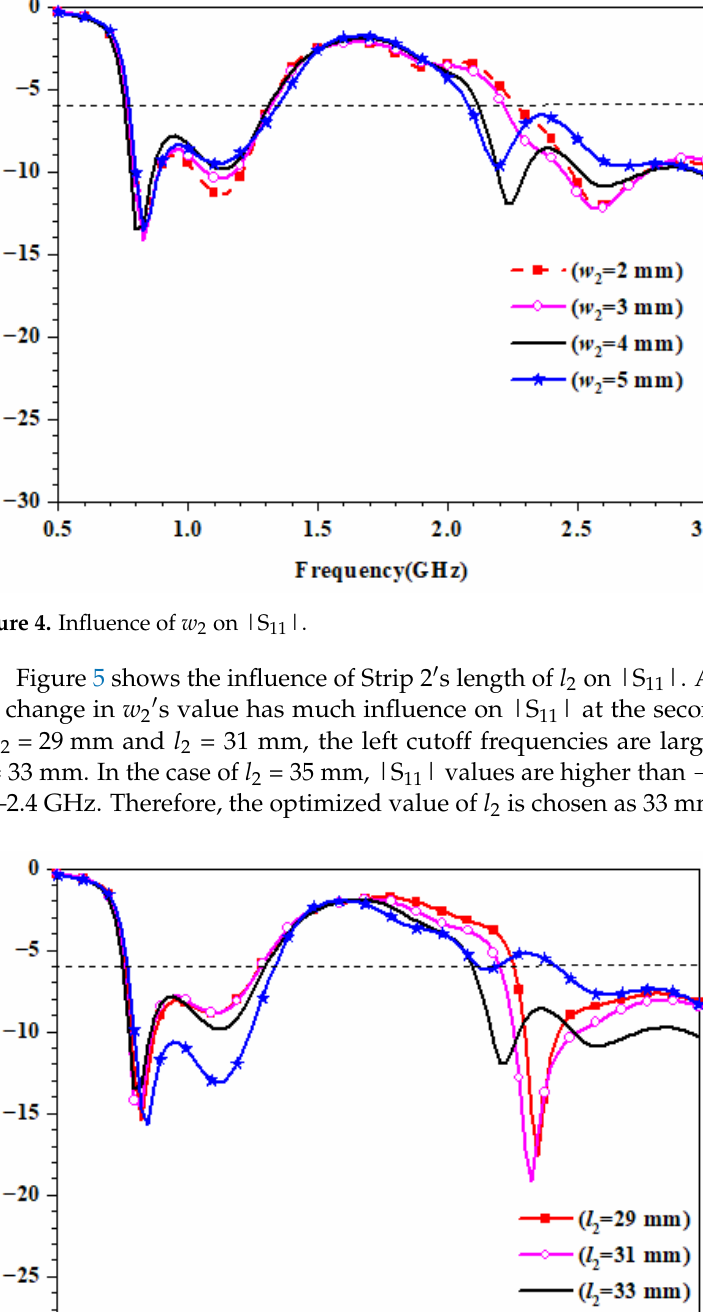
Figure 5. Influence of l 2 on |S 11 |.